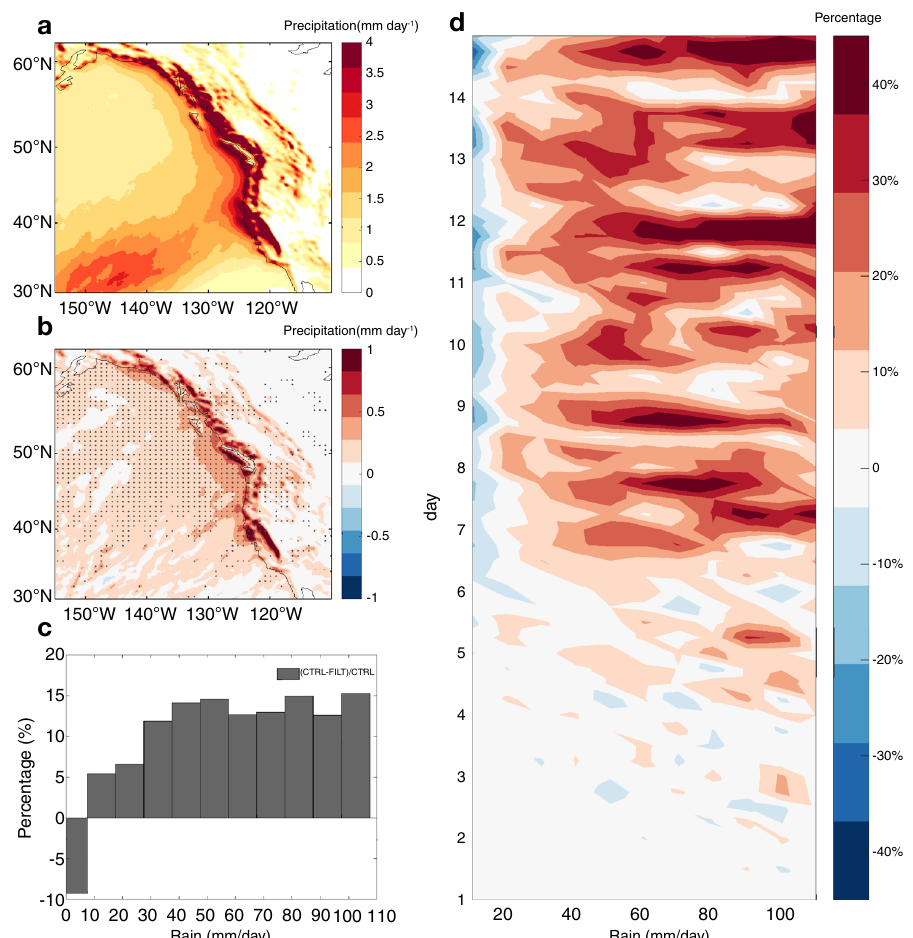
Fig. 4 Response of heavy precipitation along west coast of North America to mesoscale sea surface temperature forcing in the cyclone ensemble. Two-week mean heavy precipitation associated with landfalling atmospheric rivers (ARs) in cyclone-ensemble control (CE CTRL) ( a ) and the corresponding difference between CE CTRL and fi ltered (FILT) ( b ). Two-week mean ( c ) and time evolving ( d ) probability density function (PDF) of relative difference of 6-hourly precipitation (averaged in the magenta box in Fig. 1c) concurrent with landfalling ARs between CE CTRL and FILT in reference to CE CTRL. The mean precipitation is computed as the sum of landfalling AR-induced precipitation over the heavy precipitation days divided by the 2-week simulation period. The difference above 95% con fi dence level based on a two-sided Student ’ s t test is shaded by gray